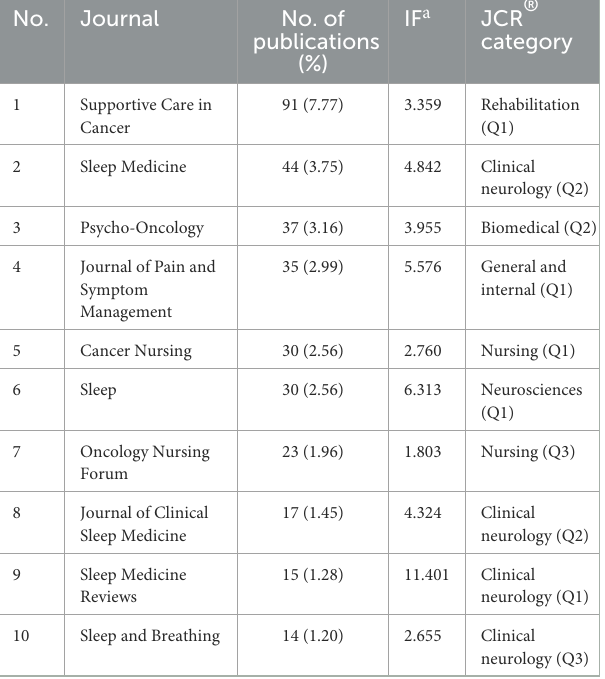
for 53.4%, exceeding the cumulative number of papers published between 2002 and 2017. The topic of cancer and sleep is still a hot field.